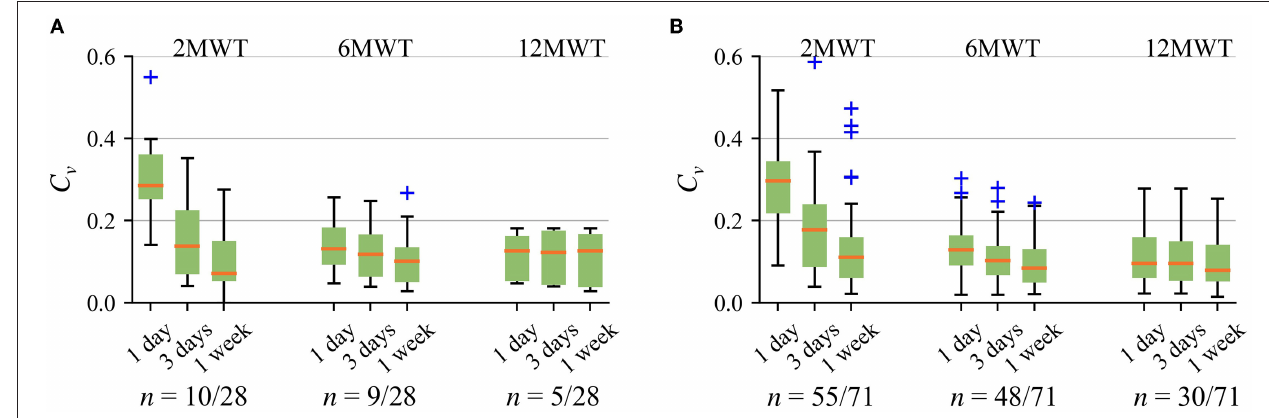
FIGURE 5 | Within-subject reproducibility using different walk test duration for different analysis time interval T ( σ ≤ 5 steps) in (A) patients with CVD and (B) healthy subjects below and over 40-years-old. Only those subjects who meet the criteria of at least three walk tests detected are included for C υ estimation. In this figure, “No σ ” means that no restriction to maximal cadence variation is applied.